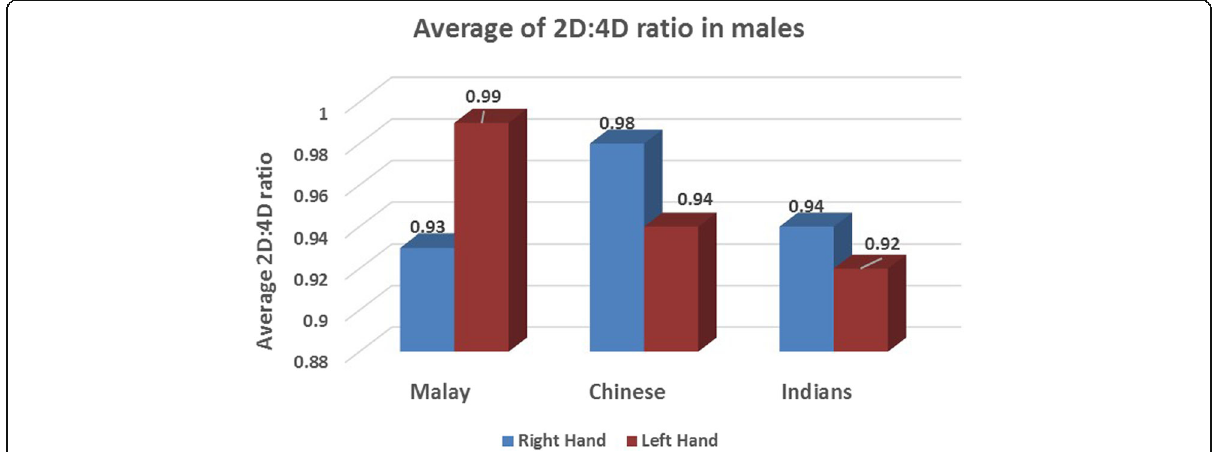
Fig. 6 Graph showing the average of 2D:4D ratio in males segregated according to races